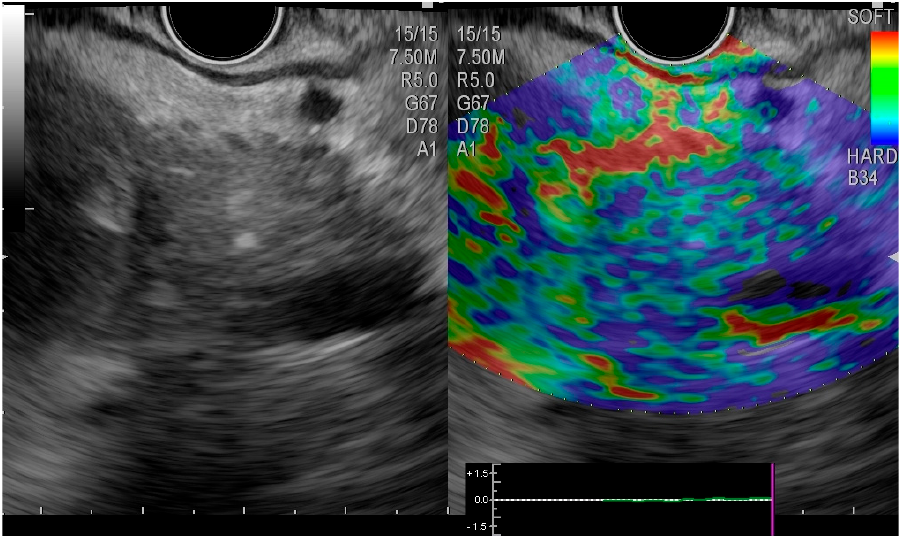
Figure 5. Endoscopic ultrasound elastography. Hypoechoic cephalic pancreatic lesion with mixed pattern.